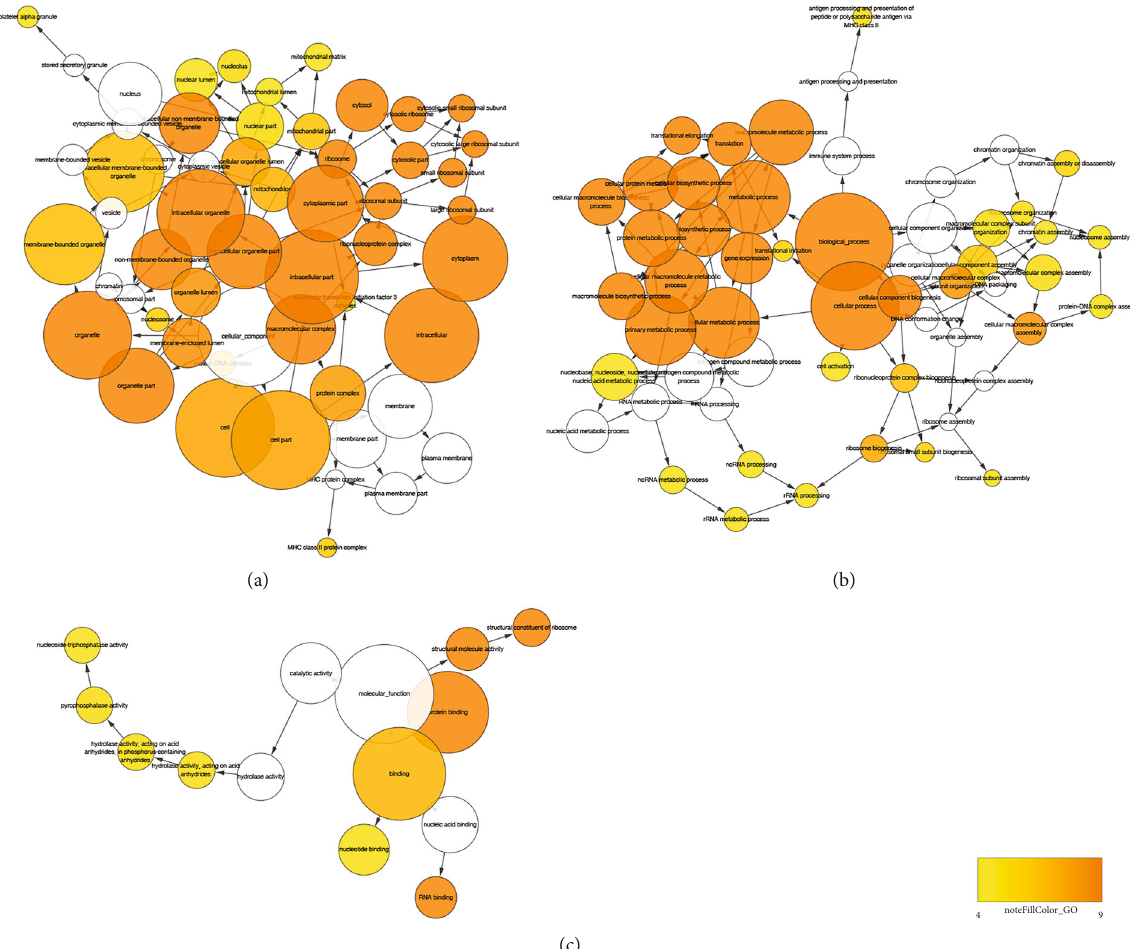
Figure 4: The network analysis of enrichment results of DEGs. (a) The enrichment of cellular components. (b) The enrichment of biological processes and the density of color were in proportion to the signi fi cance. (c) The network analysis of enrichment results of molecular functions by DEGs. The density of color was in proportion to the signi fi cance.